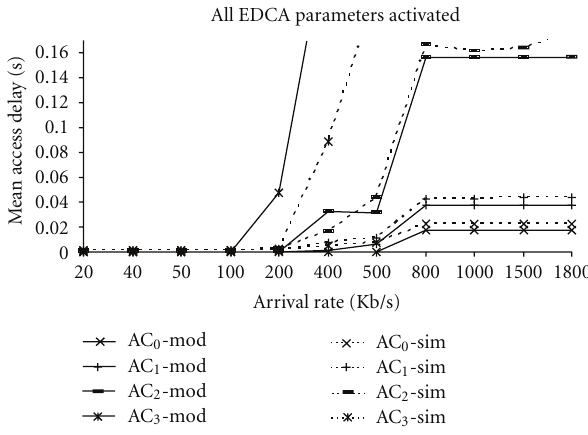
Figure 23: Access delay per AC—all parameters